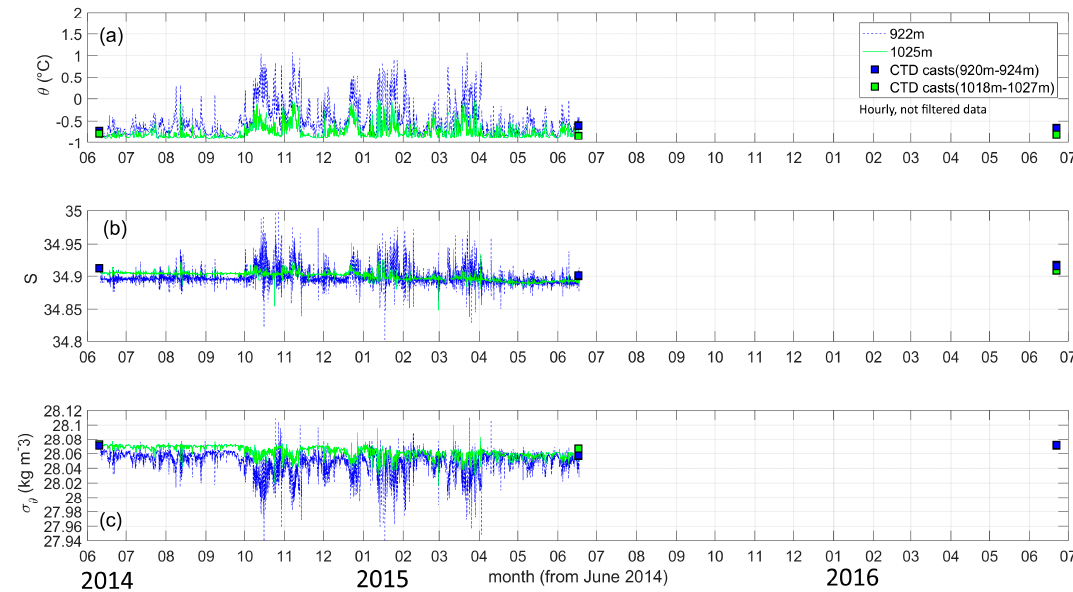
Figure 5. Time series (hourly data) of θ ( a ), S ( b ), and σ θ ( c ) at ID2 between June 2014 and June 2015 at 922 m and 1025 m depth. Green and blue squares indicate data extracted from CTD casts ( θ and S) at depths close to the moored instruments. Note that after June 2015, only temperature sensors were deployed at ID2 (see in situ temperature in Figure 6).